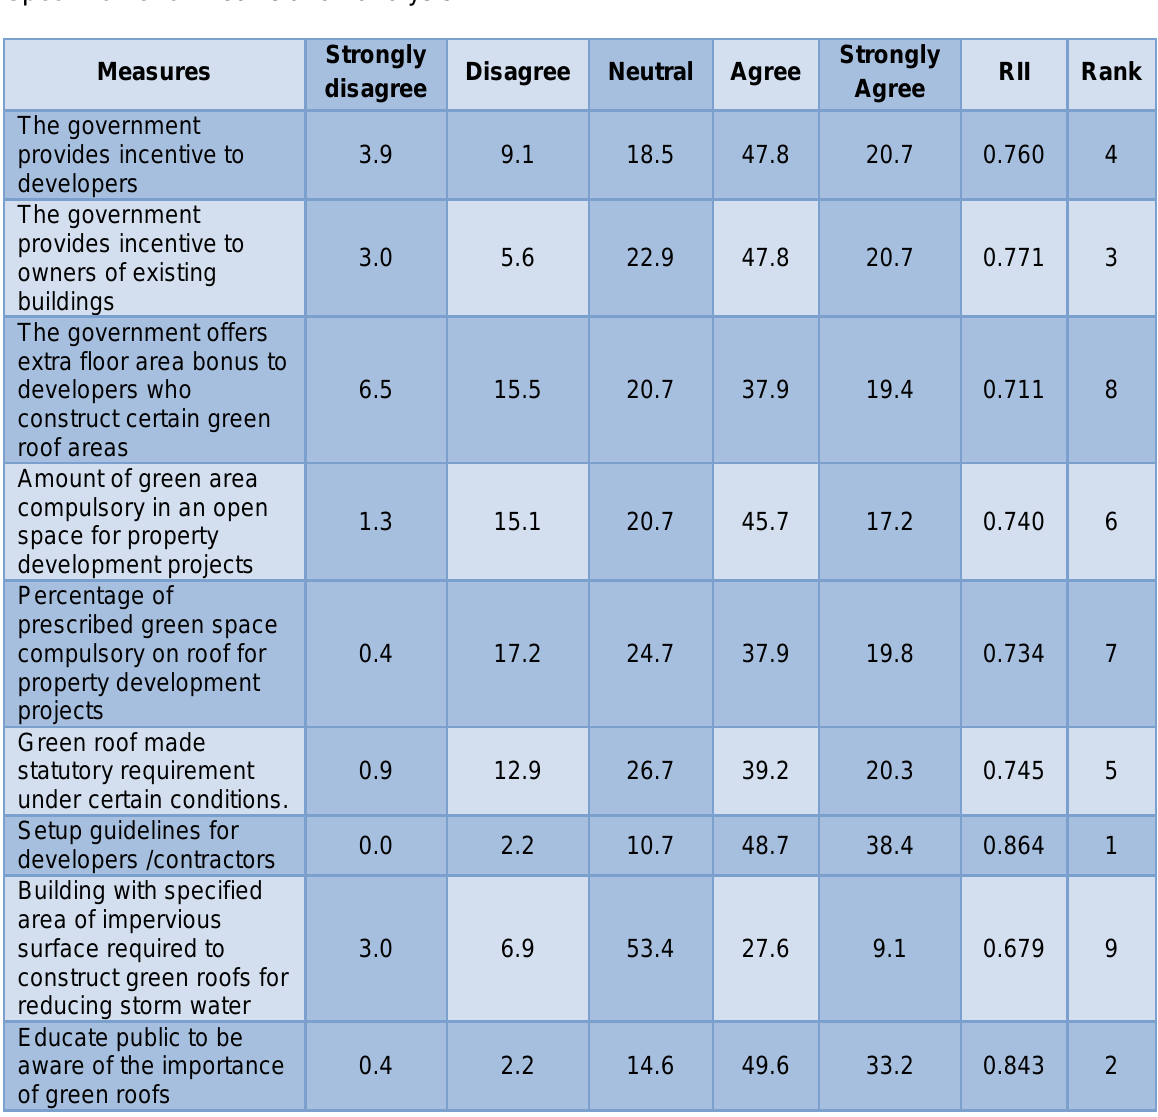
Table 9: Measures for Reducing Constraints in Implementing Extensive Green Roof Systems Practical